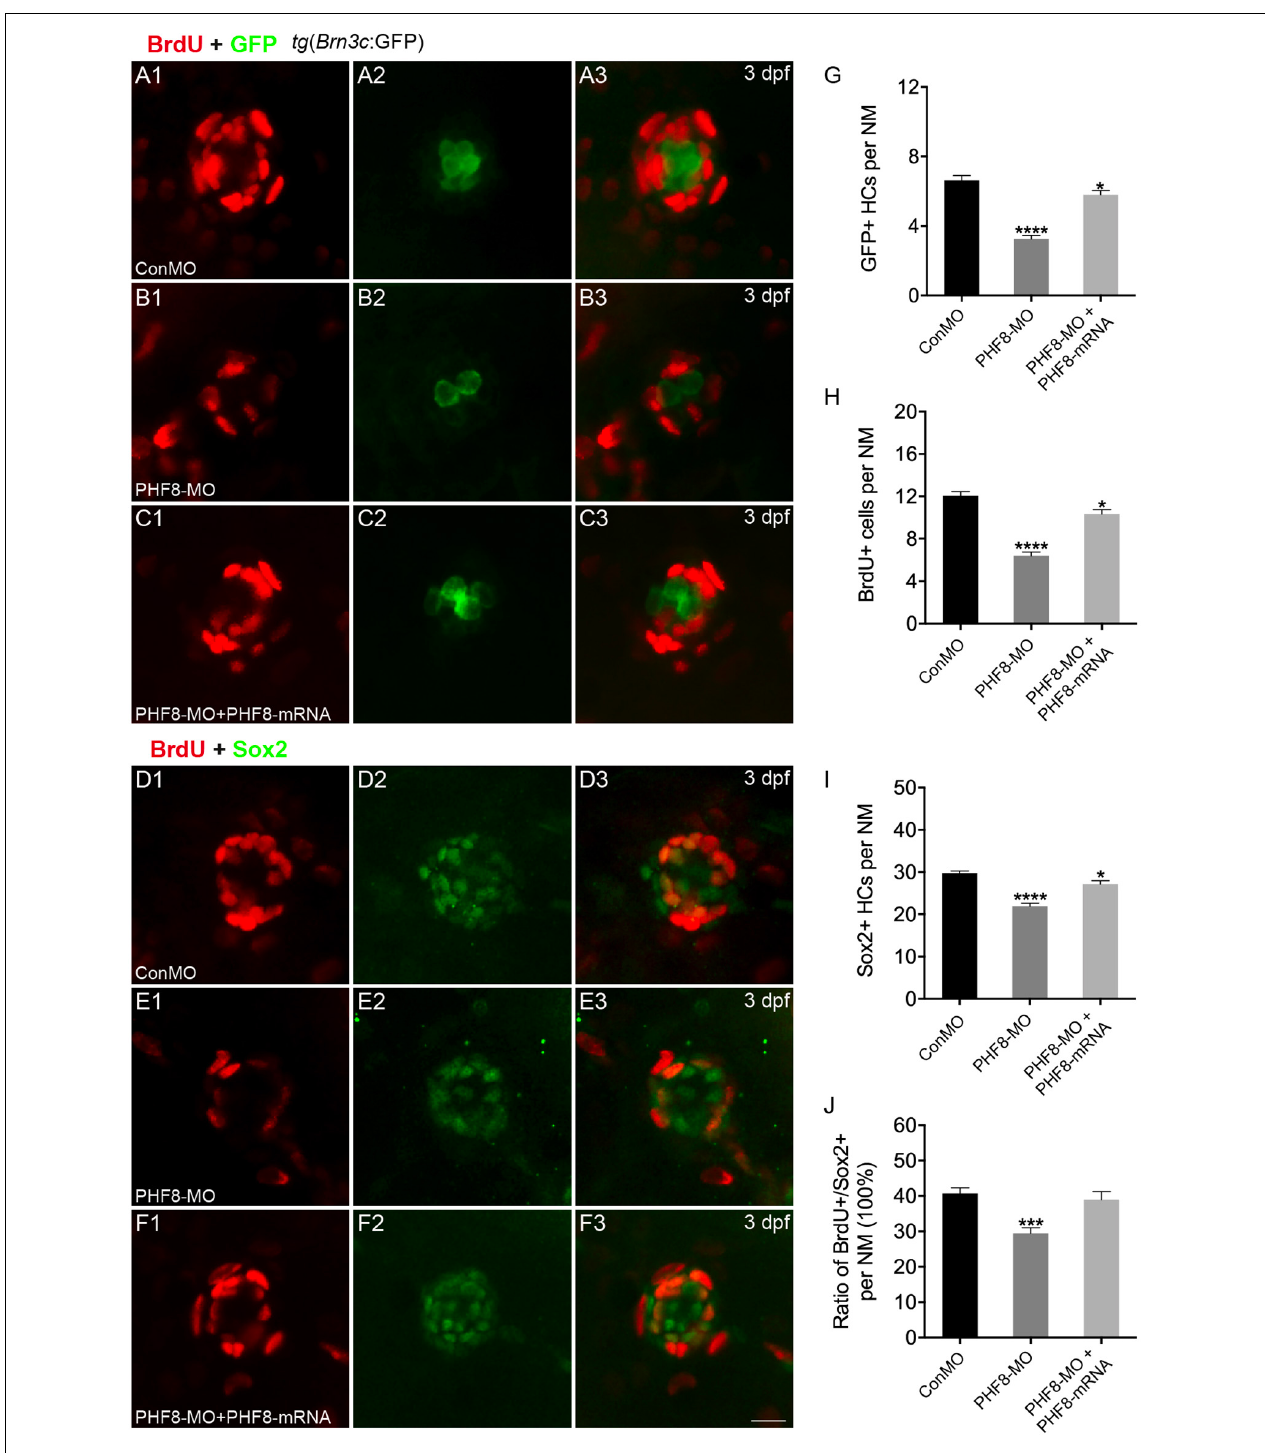
FIGURE 4 | Analysis of neuromast proliferation in PHF8 morphant. (A–C) Representative images of GFP (green) and BrdU (red) staining of neuromasts from control (ConMO; A ), PHF8 morphants (PHF8-MO; B ), and PHF8-MO co-injected with PHF8-mRNA embryo (PHF8-MO + PHF8-mRNA; C ) at 3 dpf. Hair cells were assessed with GFP visualization in transgenic line tg ( Brn3c :GFP). (D–F) Representative images of supporting cell marker Sox2 (green) and BrdU (red) staining of neuromasts from control (ConMO; D ), PHF8 morphants (PHF8-MO; E ), and PHF8-MO co-injected with PHF8-mRNA embryo (PHF8-MO + PHF8-mRNA; F ) at 3 dpf. (G–J) The average number of GFP-positive hair cells (G) , BrdU-positive cells (H) , Sox2-positive supporting cells (I) , and the ratio of BrdU + /Sox2 + cells per neuromast (NM) in control (ConMO), PHF8 morphants (PHF8-MO), and PHF8-MO co-injected with PHF8-mRNA embryo (PHF8-MO + PHF8-mRNA) at 3 dpf. n = 24 neuromasts per group, * p < 0.05, *** p < 0.001, **** p < 0.0001 vs. the ConMO group. Statistics are presented as means ± SEM. Scale bar, 10 µ m. Neuromast, NM.